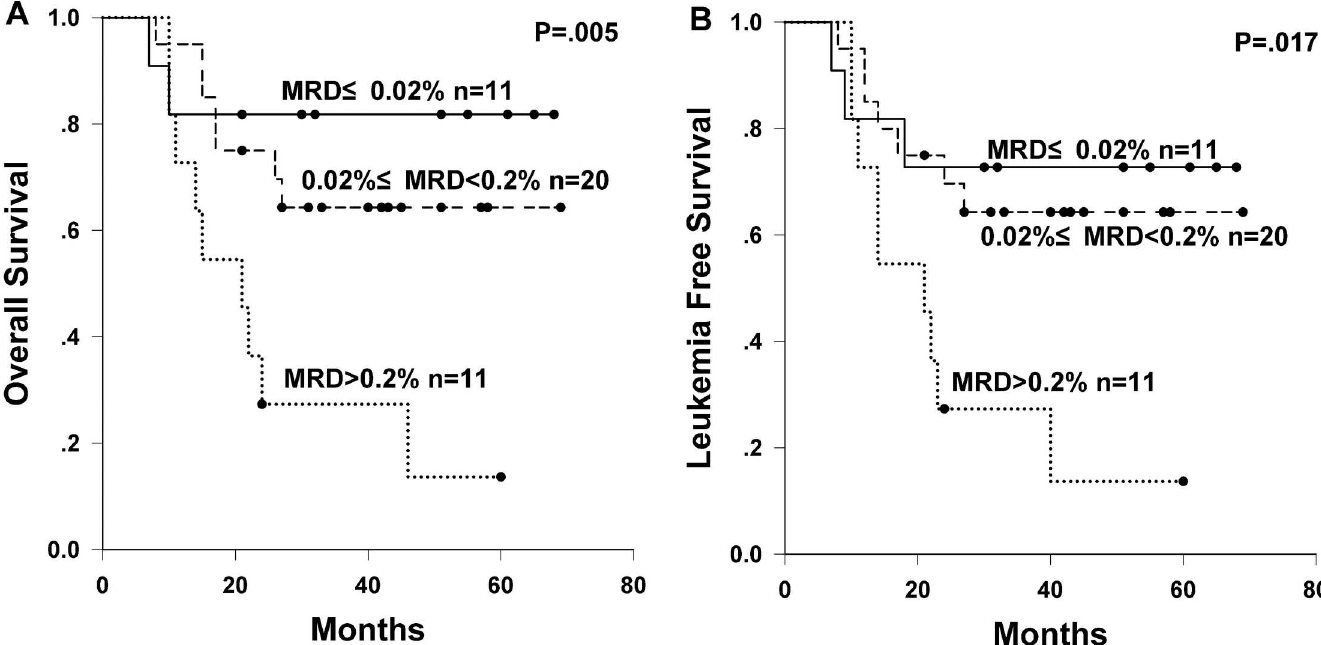
Fig 3. Survival of subgroups stratified by MRD at CR1 in the allo-HSCT arm. (A) OS and (B) LFS of subgroupsstratified by MRD at CR1 in the allo- HSCT